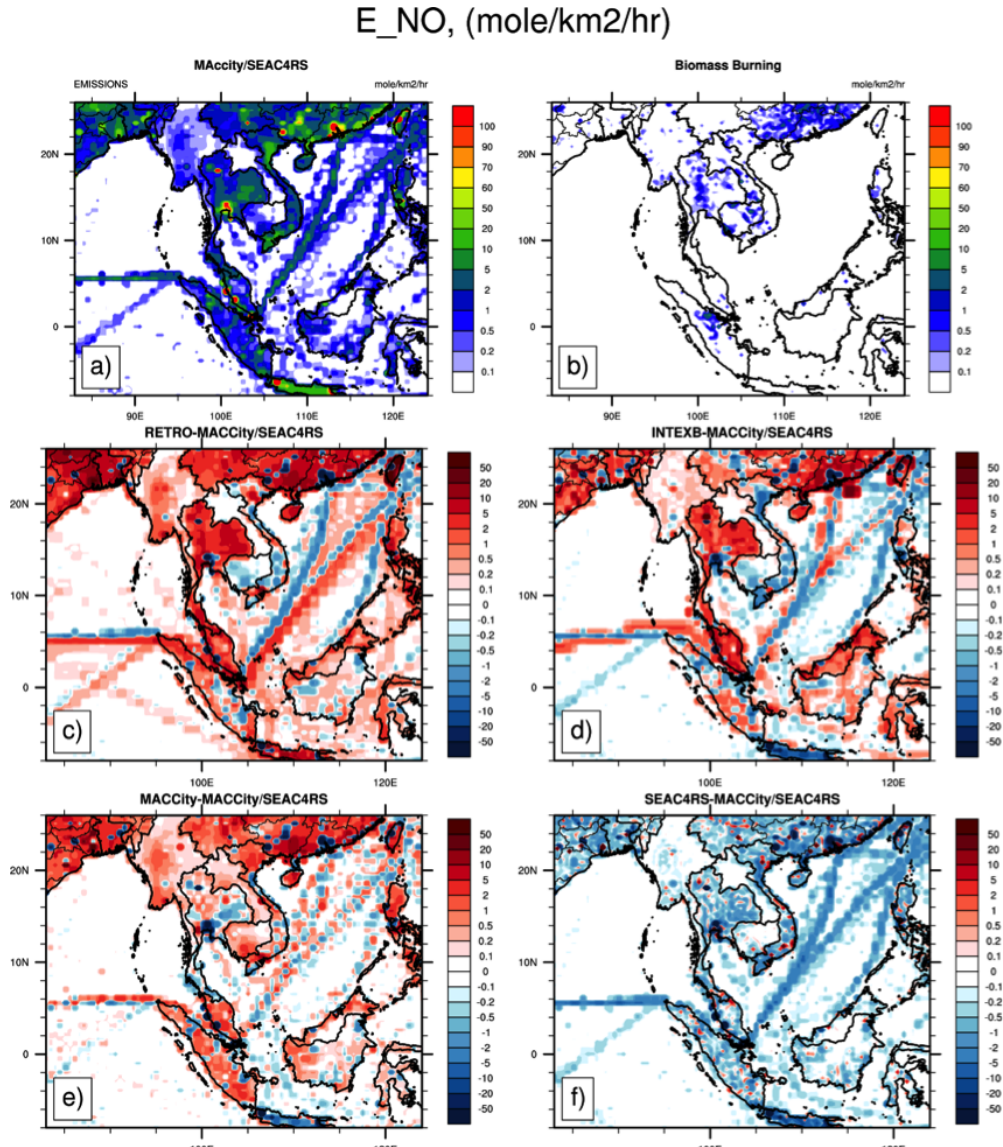
Figure 4. Nitrogen oxides emissions for December 2008 from different emission inventories: (a) MACCity–SEAC4RS, (b) biomass burn- ing, (c) RETRO - MACCity–SEAC4RS, (d) INTEX-B - MACCity–SEAC4RS, (e) MACCity - MACCity–SEAC4RS, and (f) SEAC4RS -